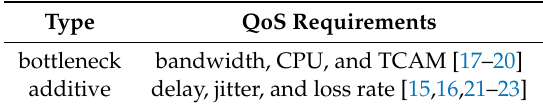
Table 1. Classification of quality of service (QoS)